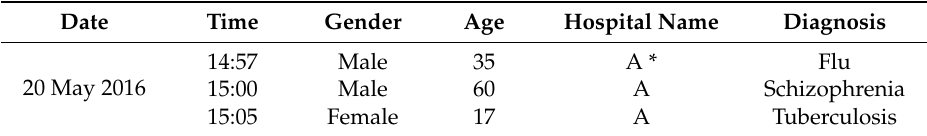
Table 1. Part of the simple, anonymous AED Big Data related to the suspected